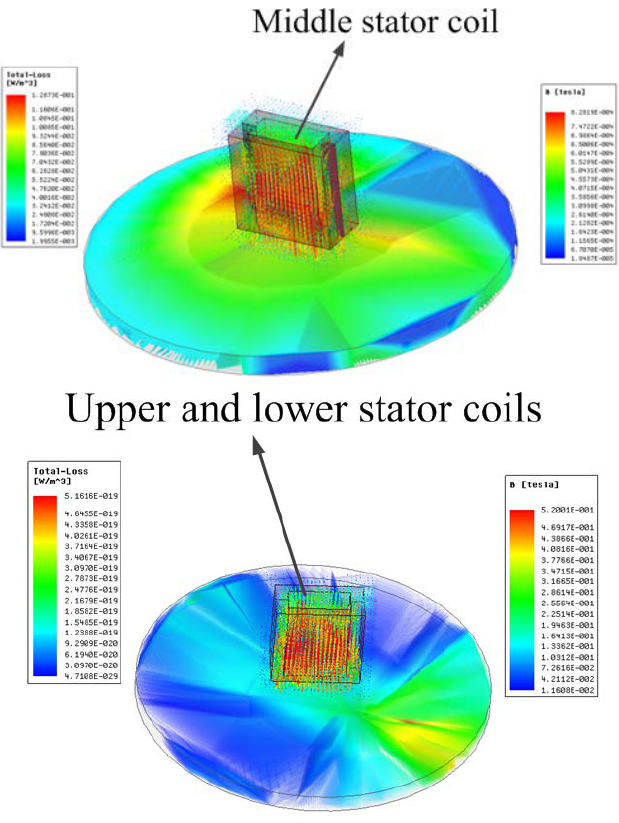
Figure 2. Eddy current distribution in different layers.